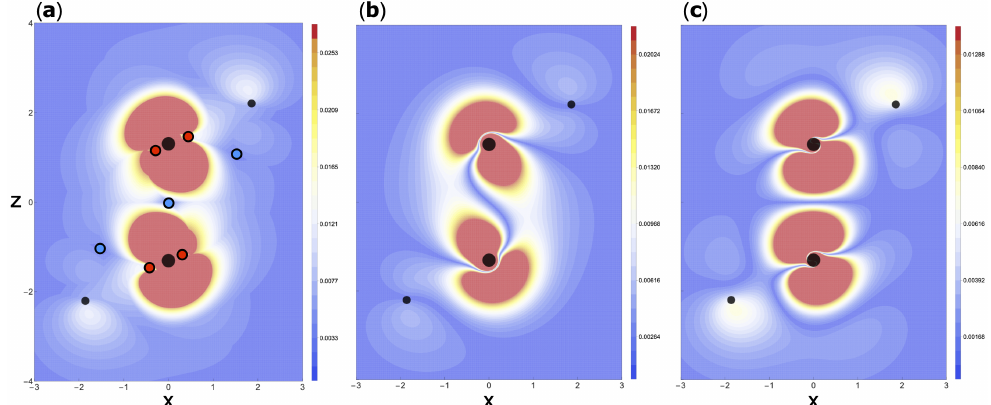
Figure 9. Contour plots of the norm of the ( a ) current density | j | , ( b ) spin α current density | j α | and ( c ) spin β current density | j β | in the xz plane of the C 2 H 2 molecule at its equilibrium geometry with a magnetic field of 0.20 B 0 along the x -axis. In ( a ), paratropic vortex lines are shown as red circles and saddle lines as blue